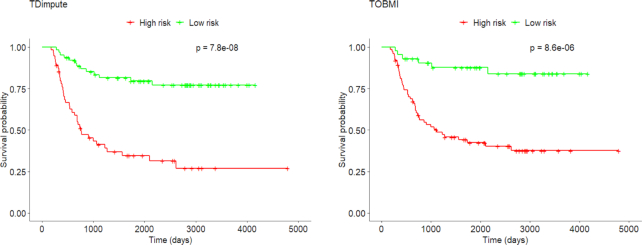
Kaplan-Meier plot for the 2 clusters obtained from the Wilms tumor dataset imputed by TDimpute and TOBMI, respectively. Censored data are marked with a small vertical bar in the graph.